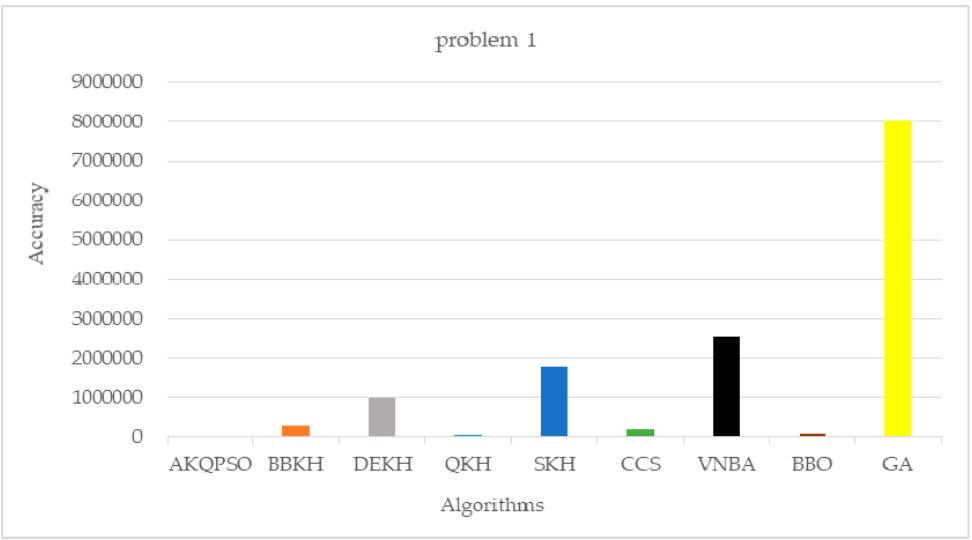
Figure 3. Accuracy of AKQPSO and other algorithms on problem 1: Storn’s Chebyshev polynomial fitting problem. BBKH, biogeography-based krill herd; DEKH, differential evolution KH; QKH, quantum-behaved KH; SKH, stud KH; CCS, chaotic cuckoo search; VNBA, variable neighborhood bat algorithm; BBO, biogeography-based optimization; GA, genetic algorithm.